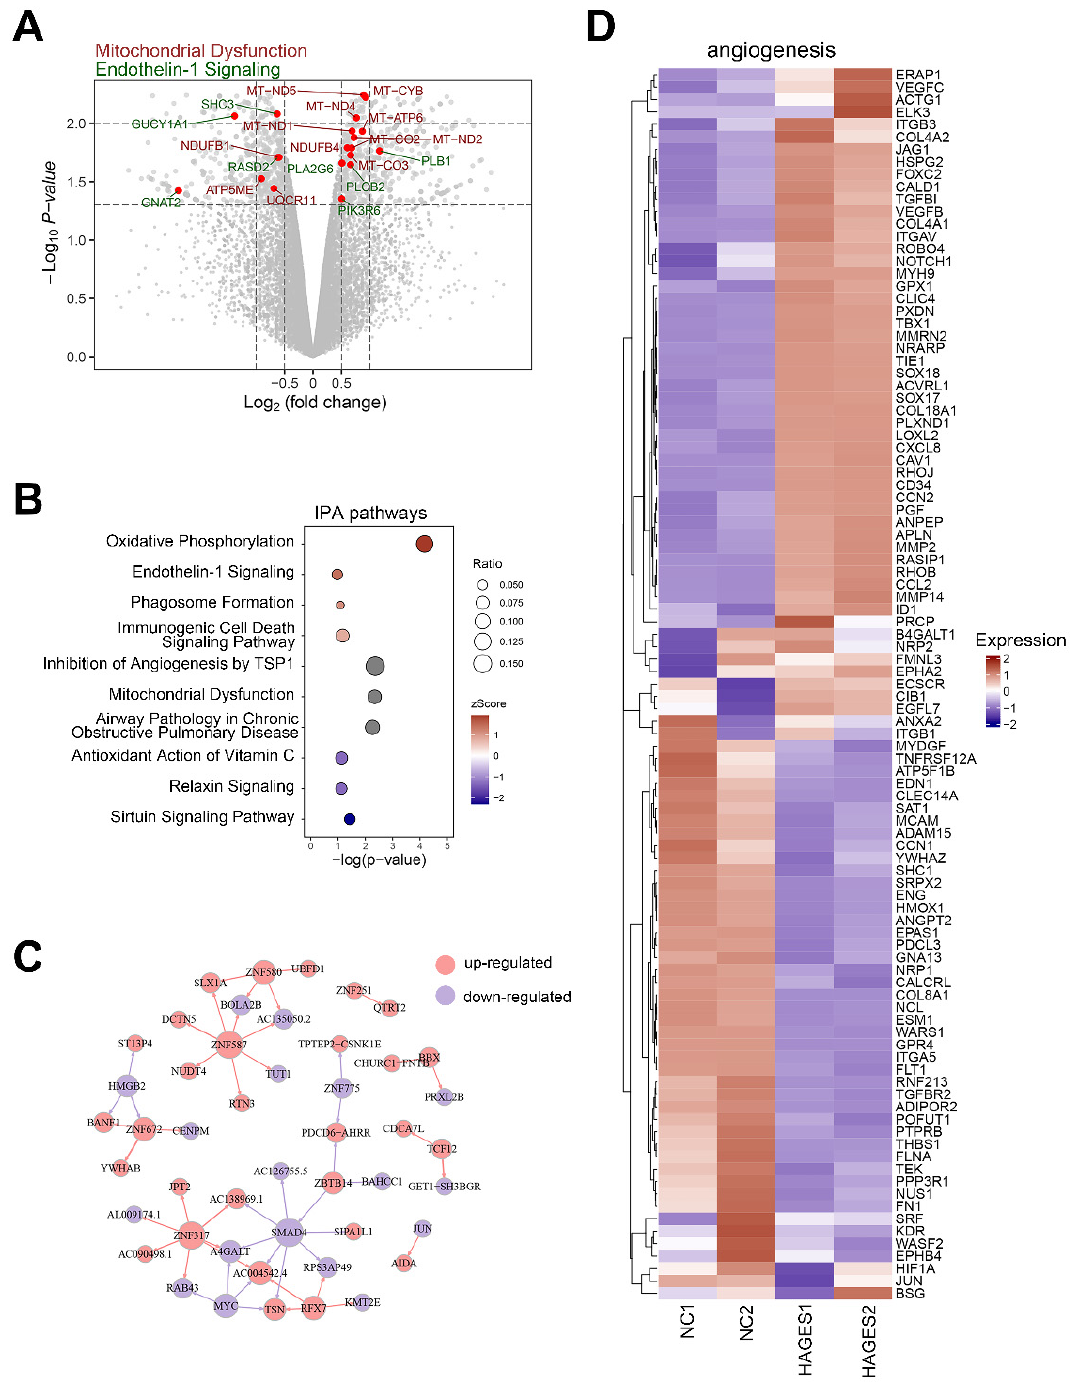
Figure 3. The transcriptome changes of CCECs after AGES treatment. ( A ) Volcano plot showing the DEGs between CCECs treated with AGES and negative controls by RNA sequencing. Genes belonging to the GO terms “Endothelin-1 Signaling” and “Mitochondrial dysfunction” are labelled with green and brown, respectively. ( B ) Bubble diagram of the enriched IPA pathway of CCECs after being treated with AGES. A gradient of light blue to red indicates inhibition to activation of the term. The size of the bubble indicates the p -value from high to low. ( C ) The transcription factors and target genes network of CCECs after being treated with AGES. The direction of the arrow indicates that the transcription factors point to the target genes, and the color of the node indicates up-regu- lation (red) or down-regulation (blue). ( D ) Heatmap shows the expression level of genes belonging to the angiogenesis GO term between CCECs treated with AGES and negative controls. A gradient of light blue to red indicates the down-regulation to up-regulation of the genes. NC: negative control (0 µg/mL AGES); HAGES: high level (100 µg/mL) of the advanced glycation end products-treated group.